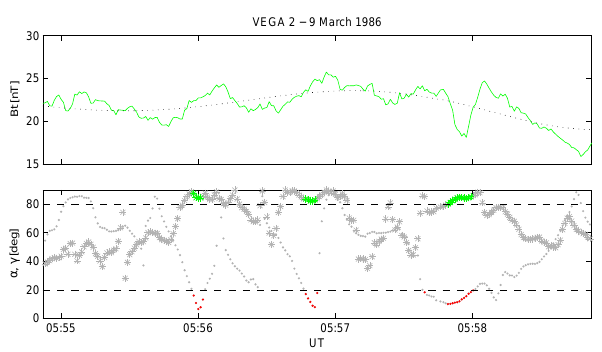
Figure 9. Example of an MM interval in the VEGA 2 data, in simi- Fig.9. ExampleofanMMintervalintheVEGA2data,insimilarformatasFig.4. lar format as Fig. 4.